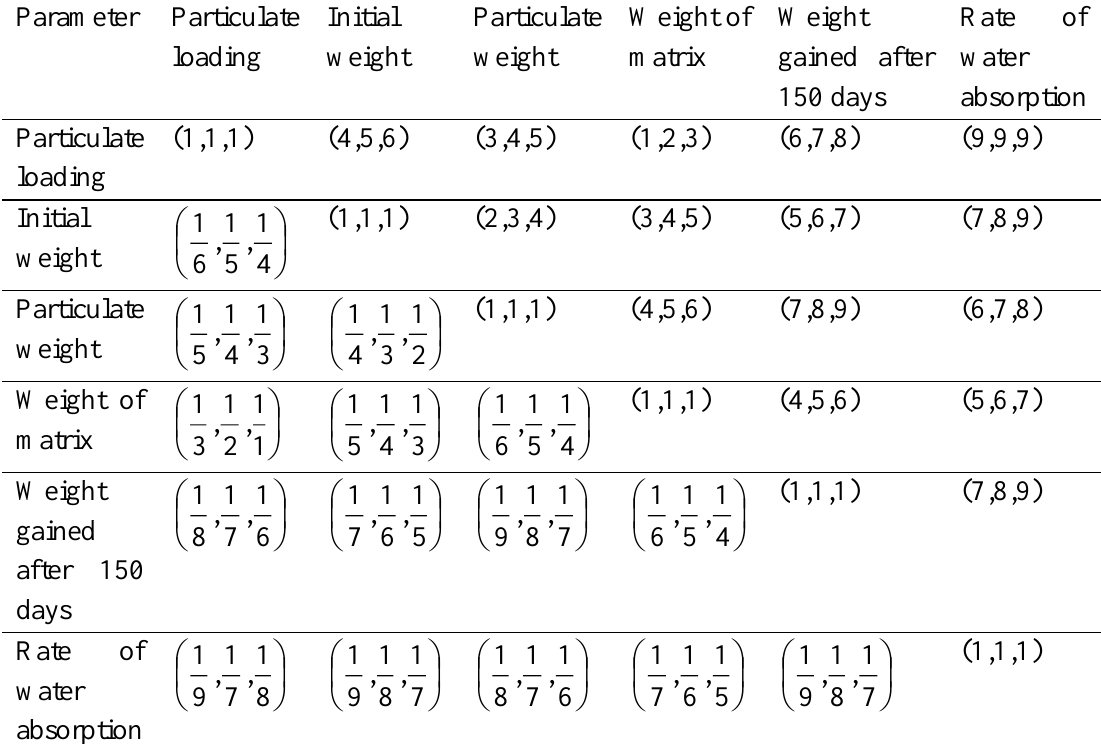
Table 3. Fuzzification pairwise comparison matrix for the cocoa pod husk composite